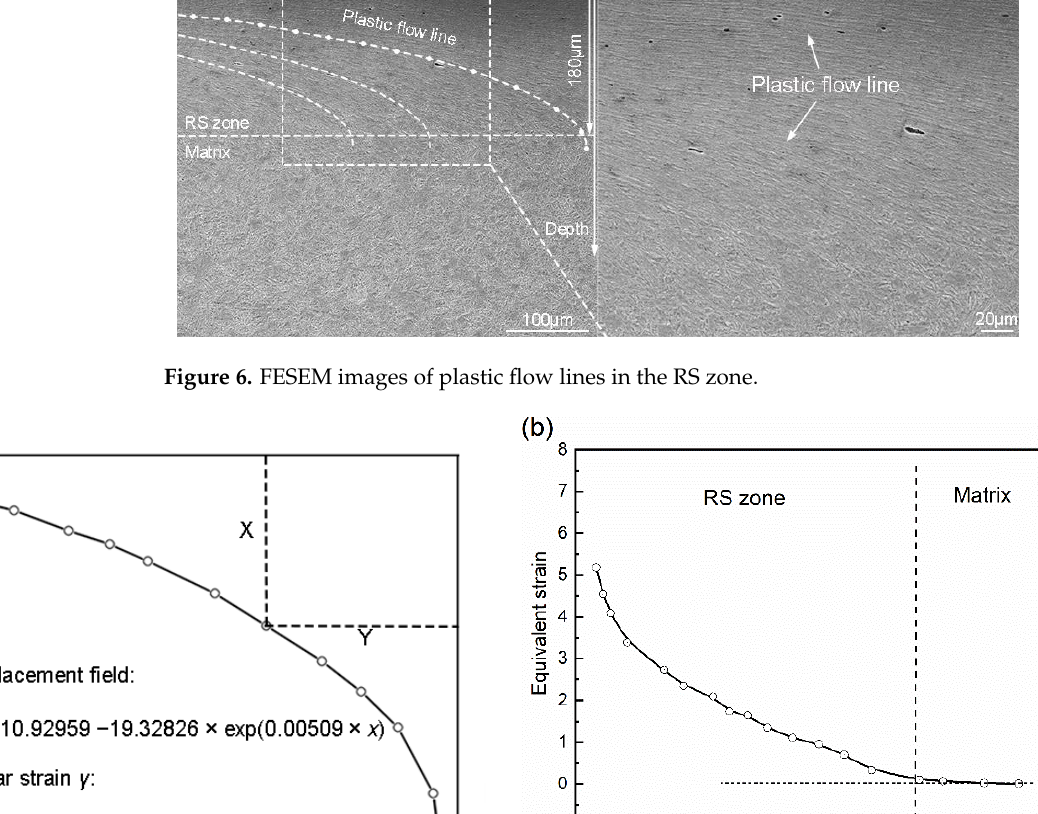
Figure 6. FESEM images of plastic flow lines in the RS zone.